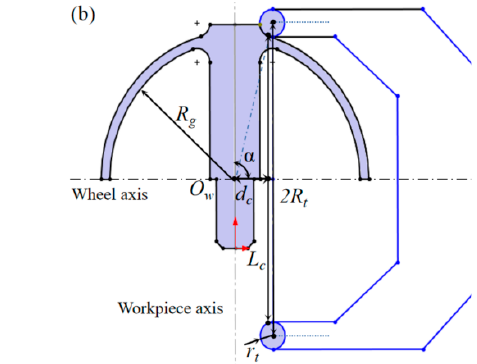
Figure 4. Tool-workpiece junction geometric model of HSR grinding: ( a ) external spherical grind- ing, ( b ) internal spherical grinding.